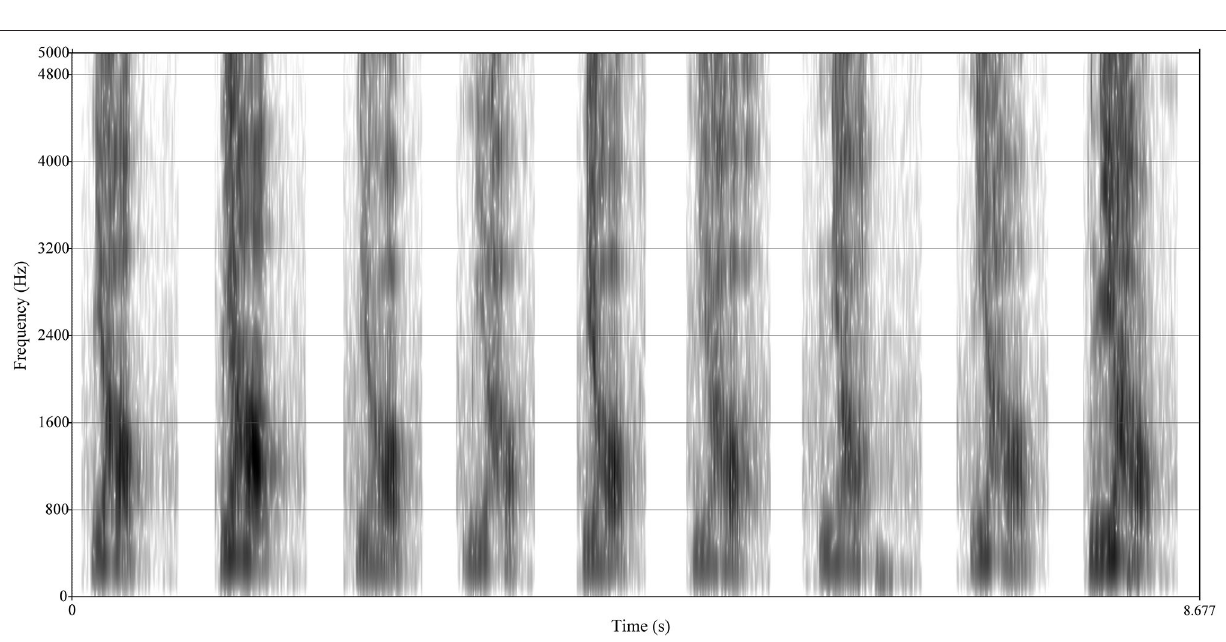
FIGURE 5 | Comparison of spectrographs of respondents among different emotions. The Y -axis of the spectrograph is the same as the waveform and expresses the amplitude. The X -axis represents frequency (unit: Hz). The frequency spectrum is the variation of voice energy with frequency. In addition, different amplitudes (or loudness) were expressed by the color gradient of data